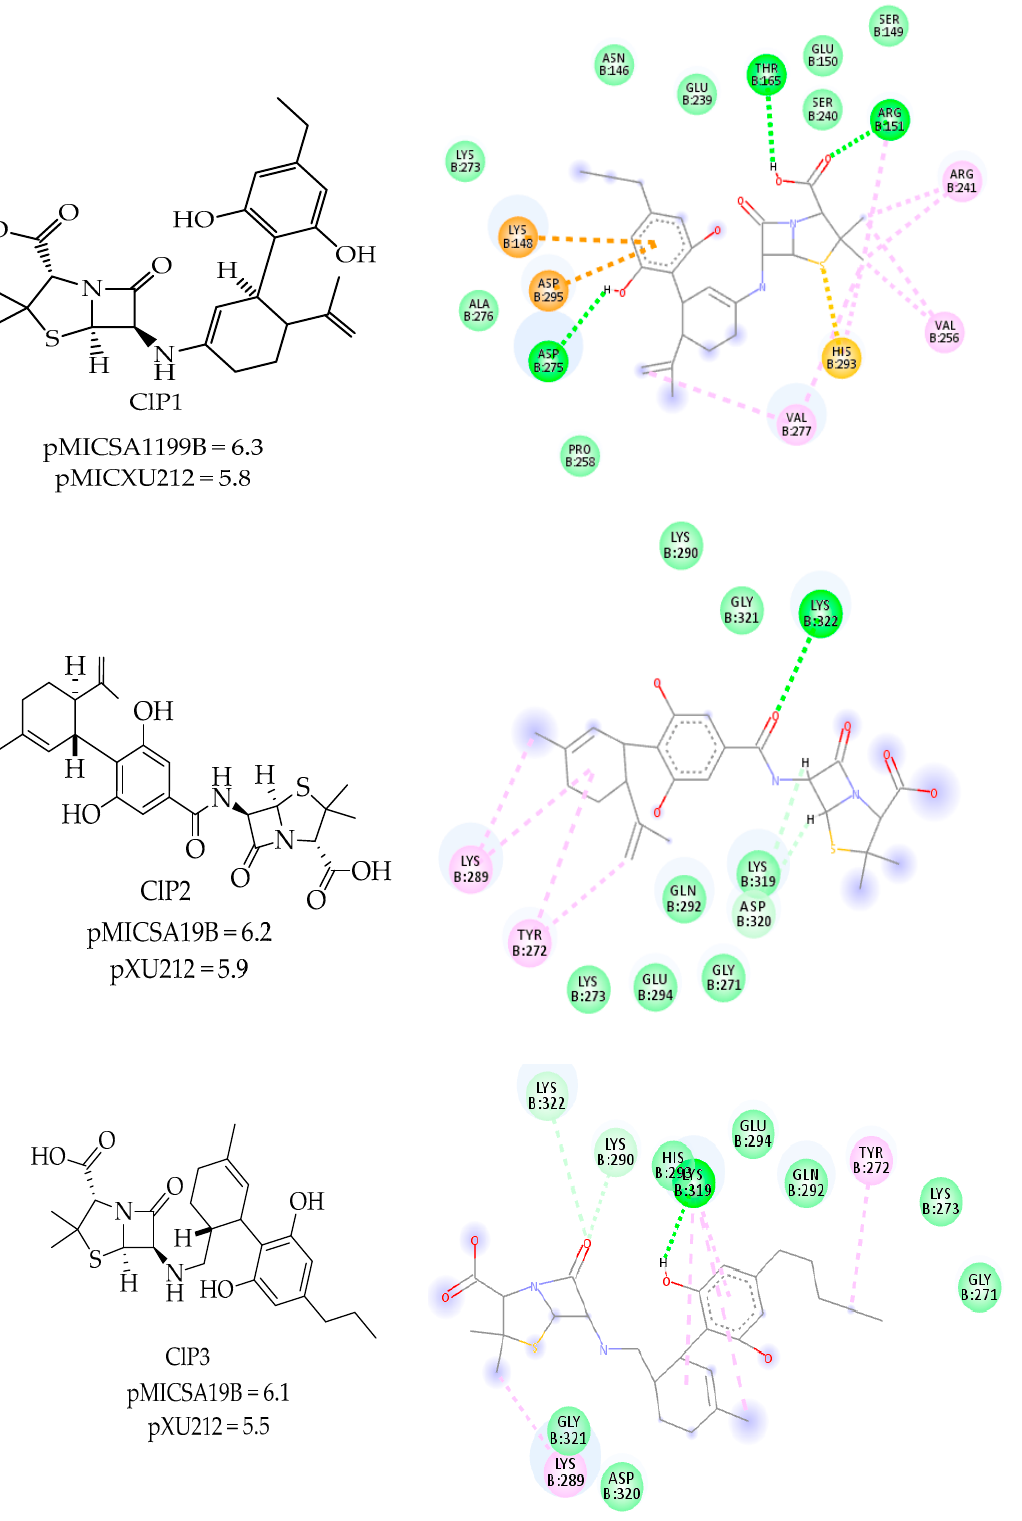
Figure 5. Left: the molecular structures of the three new potentially anti-MRSA compounds and their predicted activity. Right: the 2D diagrams of the molecular interactions in the active site of the PBP.